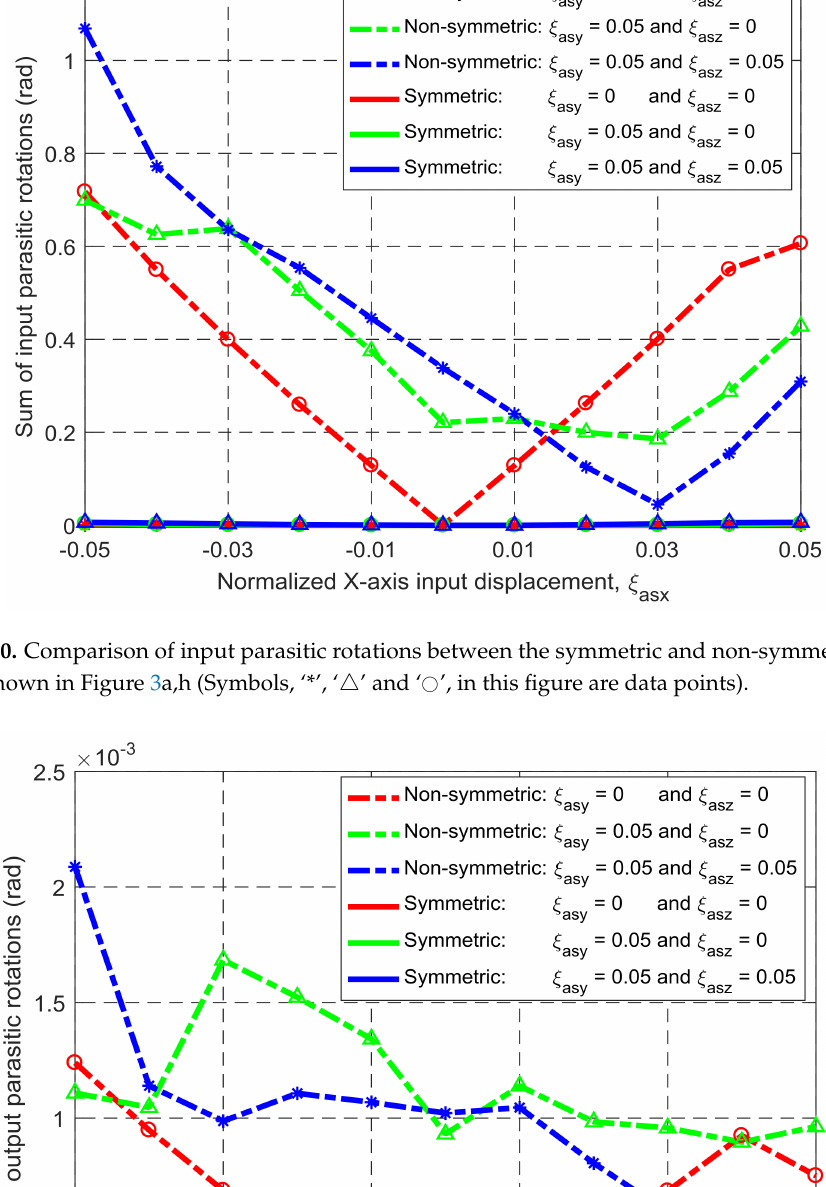
Figure 11. Comparison of output parasitic rotations between the symmetric and non-symmetric XYZ CPMs shown in Figure 3a,h (Symbols, ‘*’, ‘ (cid:52) ’ and ‘